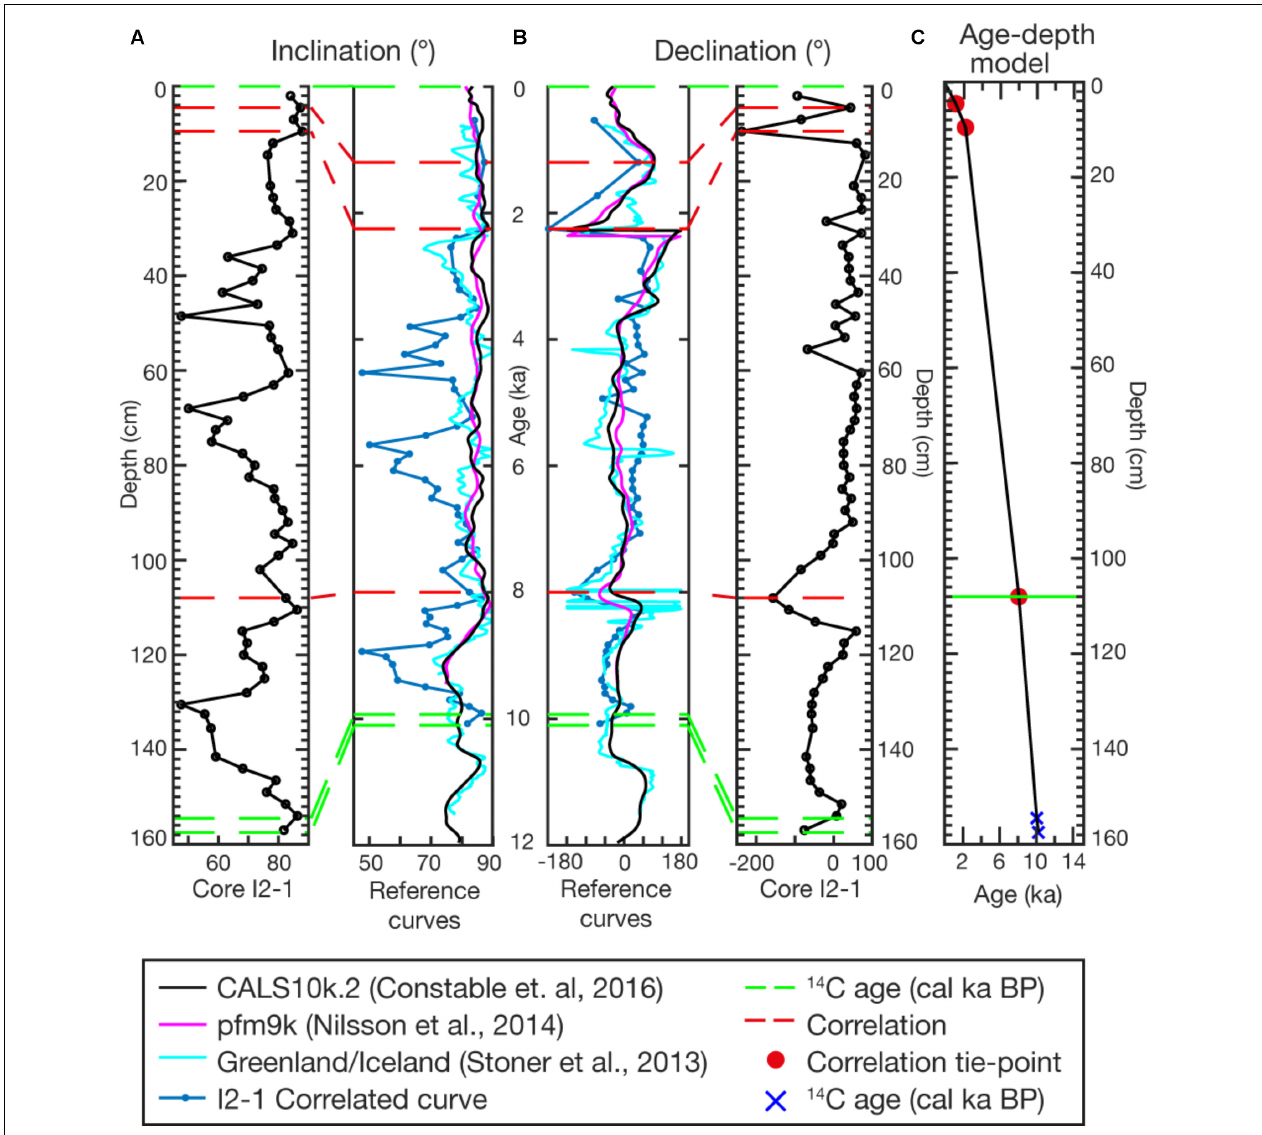
FIGURE 8 | Correlation of paleomagnetic measurements of (A) inclination and (B) declination in Core I2-1 to three reference curves (see Legend). Stippled lines indicate correlation points. Green stippled lines are constraints based on 14 C ages. The resulting age-depth model for core I2 is shown in (C)